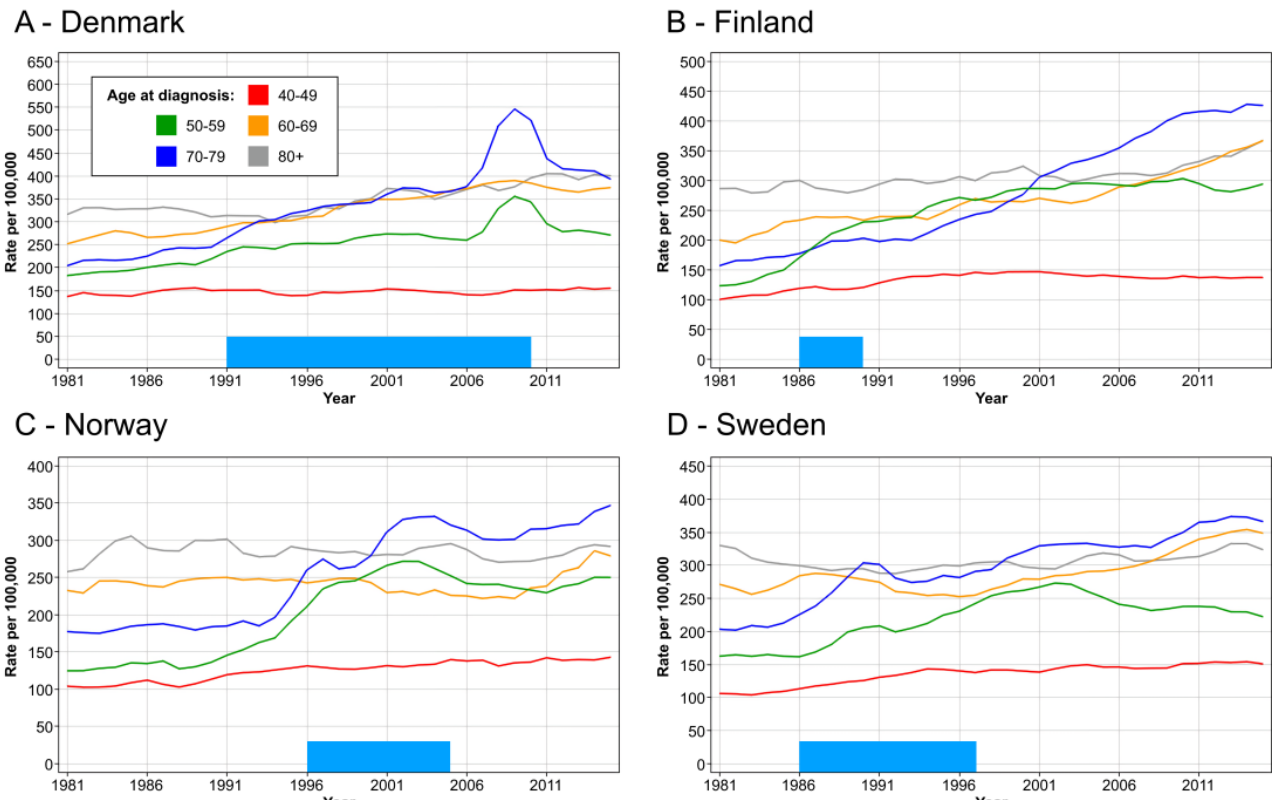
Figure 1. Age specific incidence for female breast cancer in DK ( A ), FI ( B ), NO ( C ) and SE ( D ). The bar in the bottom shows the approximate time of rolling out the mammographic screening to the national level.